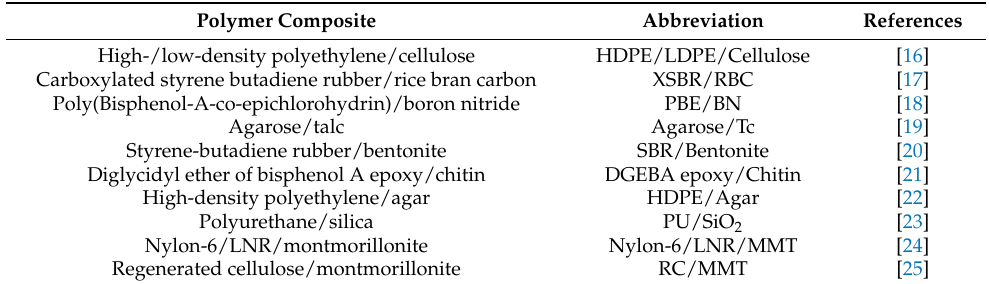
Examples of polymer composites compatibilized by quaternary ammonium com- pounds (QACs).